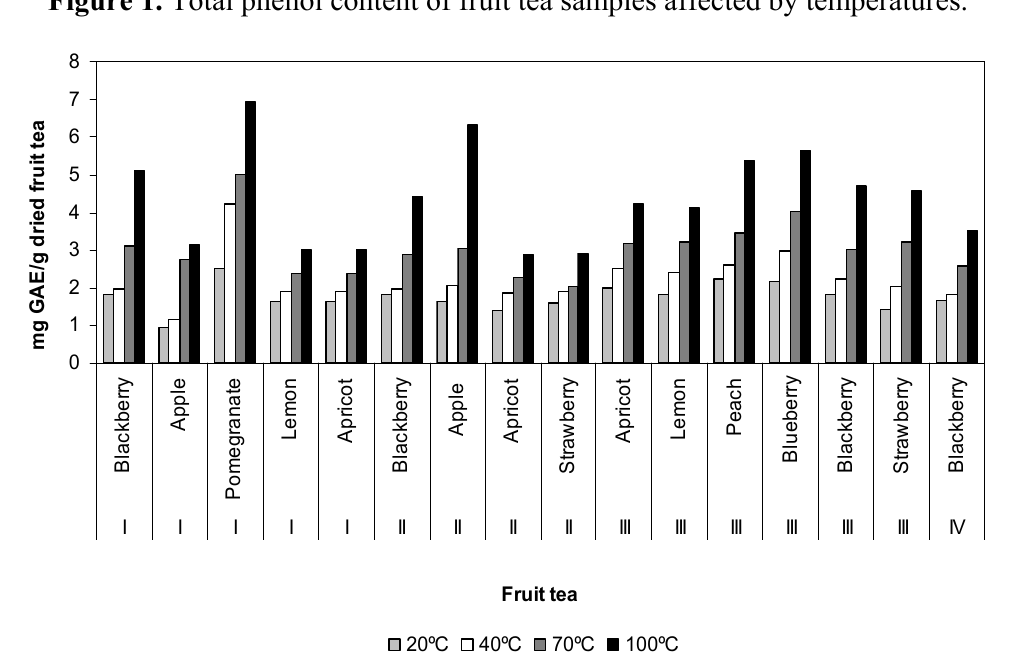
Figure 1. Total phenol content of fruit tea samples affected by